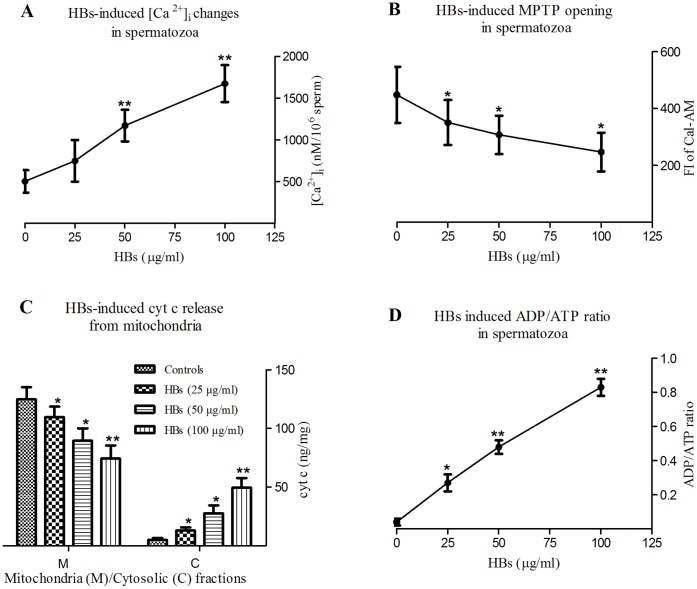
HBs induced early apoptotic events in human spermatozoa.A: The average [Ca2+]i rose with increasing concentrations of HBs. There are marked significant differences in the average [Ca2+] i in 50 µg/ml and 100 µg/ml HBs groups when compared with that in the control (P<0.01). The high levels of [Ca2+] i induced by HBs would be a signal to trigger apoptosis. B: In contrast, FI of Cal-AM declined with increasing concentrations of HBs. There are significant differences in FI between the control and test groups (P<0.05). This suggested that MPTP opening has occurred, and the extent of pore opening increased with increasing concentrations of HBs. C: the levels of cyt c in mitochondria fractions declined with increasing concentrations of HBs, in parallel, the levels of cyt c in cytosolic fractions rose with increasing concentrations of HBs. There are significant differences in levels of cyt c in all test groups as compared to that in control (P<0.05 or P<0.01). This suggested that cyt c was released from mitochondria to cytoplasm through the MPTP. D: The ADP/ATP ratio rose with increasing concentrations of HBs. There are significant differences in ADP/ATP ratio between the control and all test groups (P<0.01). It indicated that spermatozoa underwent apoptosis induced by HBs. In all above events, effects of HBs exposure on spermatozoa showed dose dependency.